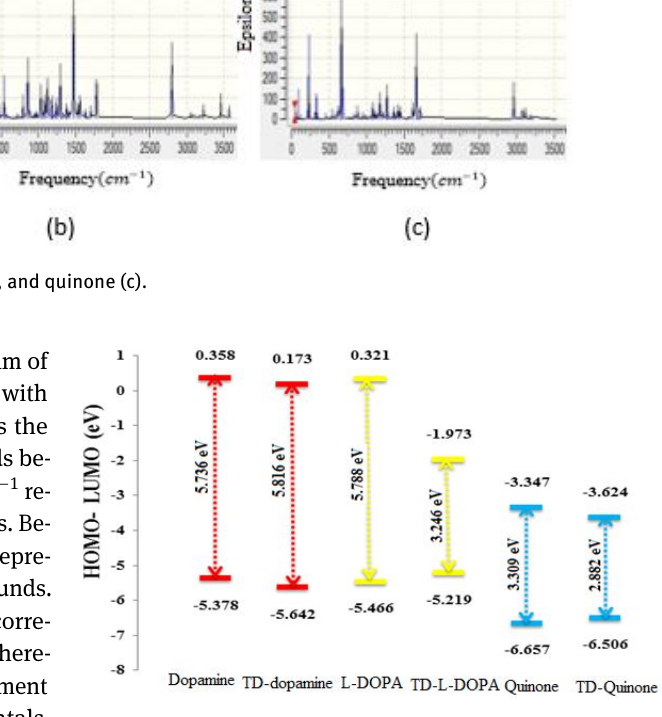
Figure 4: The values of LUMO (in the top), HOMO (in the bottom) and energy gap for dopamine derivatives at two states (ground and excite